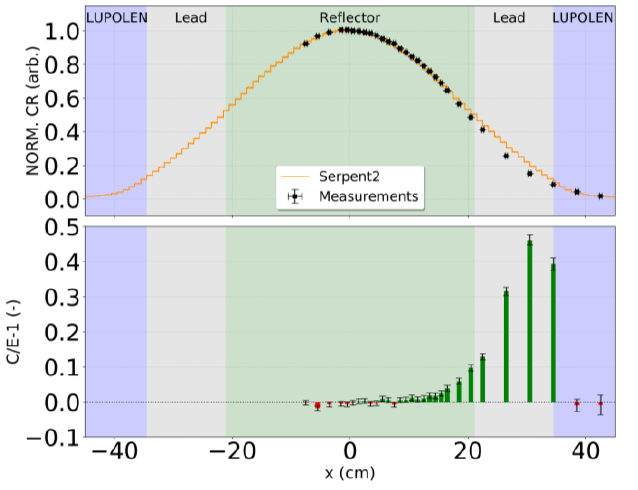
Fig. 9 - Comparison between experimental and simulated results for the thermal neutron flux distribution in tangential channel